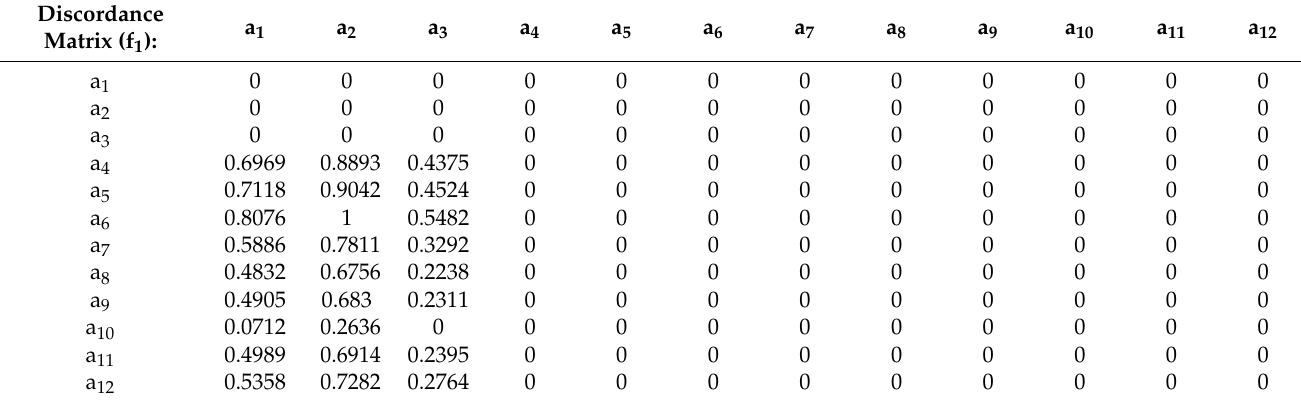
Table A1. Values of the non-compliance indicators according to the 1st criterion.